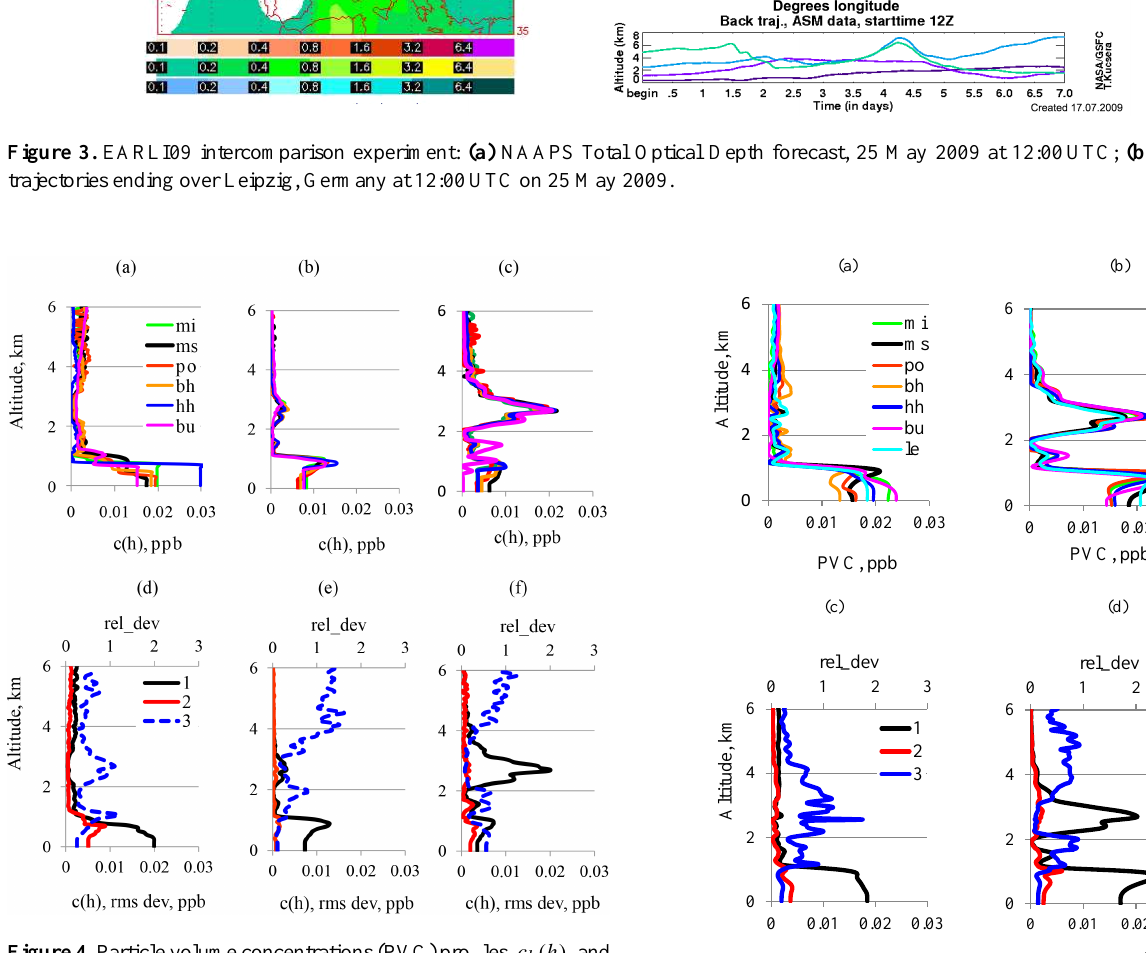
Figure 4. Particle volume concentrations (PVC) profiles, c k (h) , and estimated deviations retrieved from data of EARLI09 intercompari-